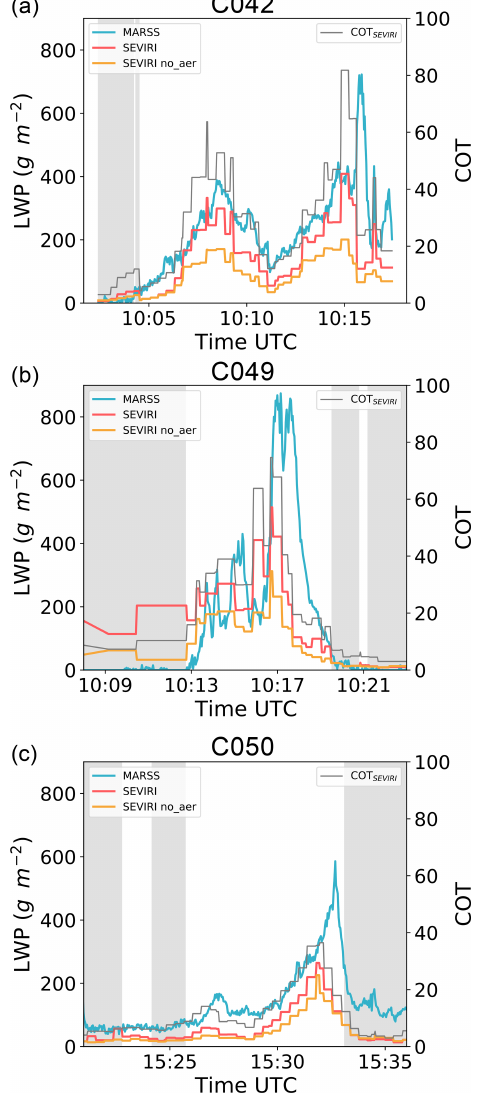
Figure 11. Comparison of the LWP measured from MARSS (blue) during straight level run above the clouds from flights C042 (a) , C049 (b) and C050 (c) and collocated LWP from SEVIRI calcu- lated based on the COT and CER retrieved with (red) and without (orange) taking into account the absorption of aerosol above clouds. The COT retrieved by SEVIRI taking into account the overlying aerosols is plotted in black. The grey areas correspond to the SE- VIRI pixels that are rejected because of the filters on cloud inhomo- geneity, cloud edges and/or unsatisfying fit of the measurements by the forward model.